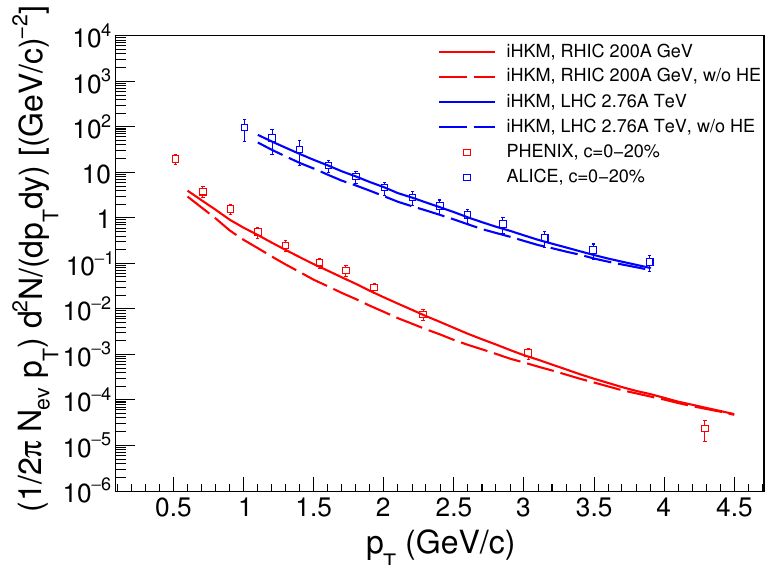
Figure 1. The photon spectra calculated within the iHKM for the RHIC 200 A GeV and the LHC 2.76 A TeV A+A collisions, in comparison with the corresponding experimental data [25,28]. The events from the centrality class c = 0–20% are analyzed. The solid lines are related to the simula- tions where the hadronization emission is taken into account, while the dashed lines represent the simulations where HE was ignored.